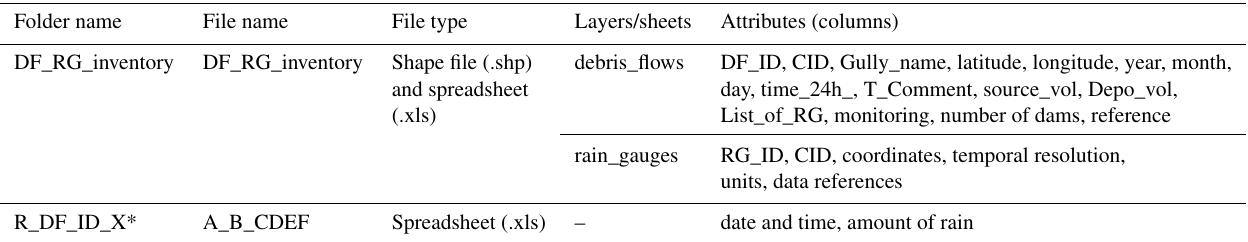
Table 6. Structure of the dataset of debris flows and their triggering rainfalls. An additional shape file is provided to define the catchment boundaries with a simple characterisation (CID, catchment name and county, gradient and internal relief, drainage density and channel